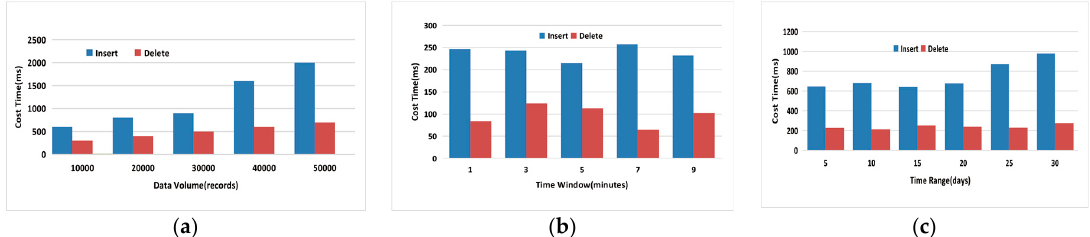
Figure 9. Comparison study for Updating: ( a ) Varying Data Volume; ( b ) Varying Time Window; ( c ) Varying Time Range.